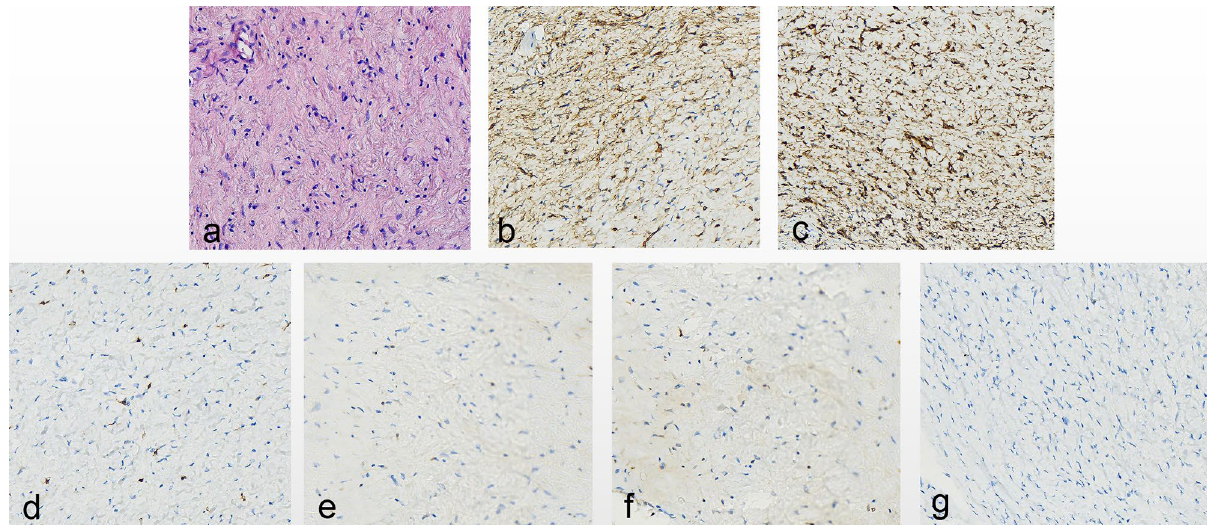
Figure 4. ( a ) H&E staining showed spindle cell proliferation and onion peel-like structures surrounding the blood vessels in a whorled pattern (X20). ( b ) CD34 positive expression (X20). ( c ) Vimentin positive expression (X20). ( d–f ) CD117/DOD-1/s-100 was not expressed (X20). ( g ) The Ki-67 proliferation index was low